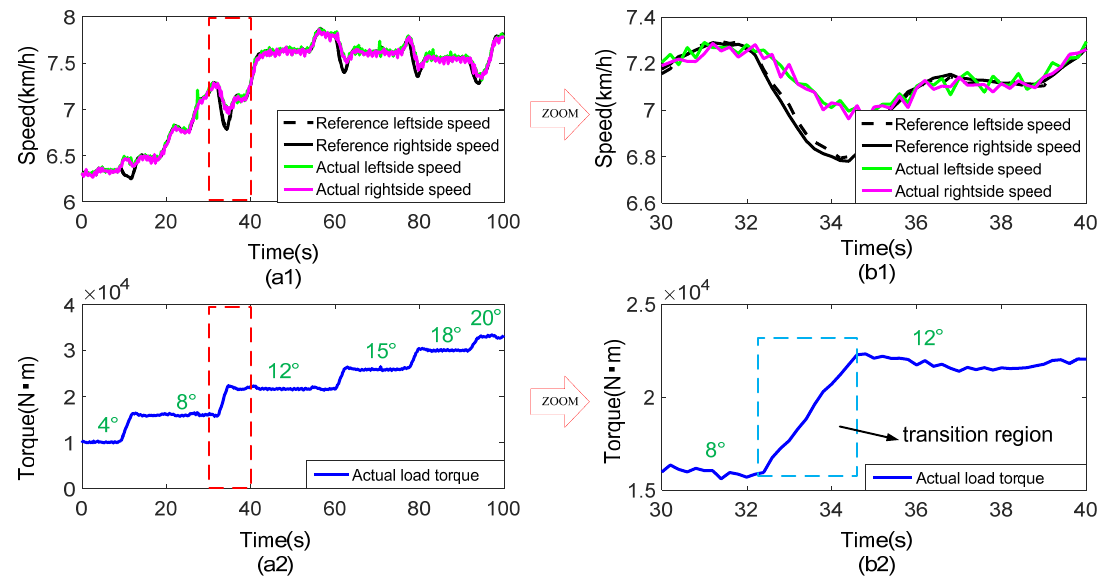
Figure 13. Experimental result under the driving condition of straight line with slopes with vehicle mass 30 t: ( a1 ) Speed tracking performance; ( a2 ) Actual total load torque of the vehicle on the test bench; ( b1 , b2 ) are partial enlargements of the figure ( a1 , a2 ), respectively.